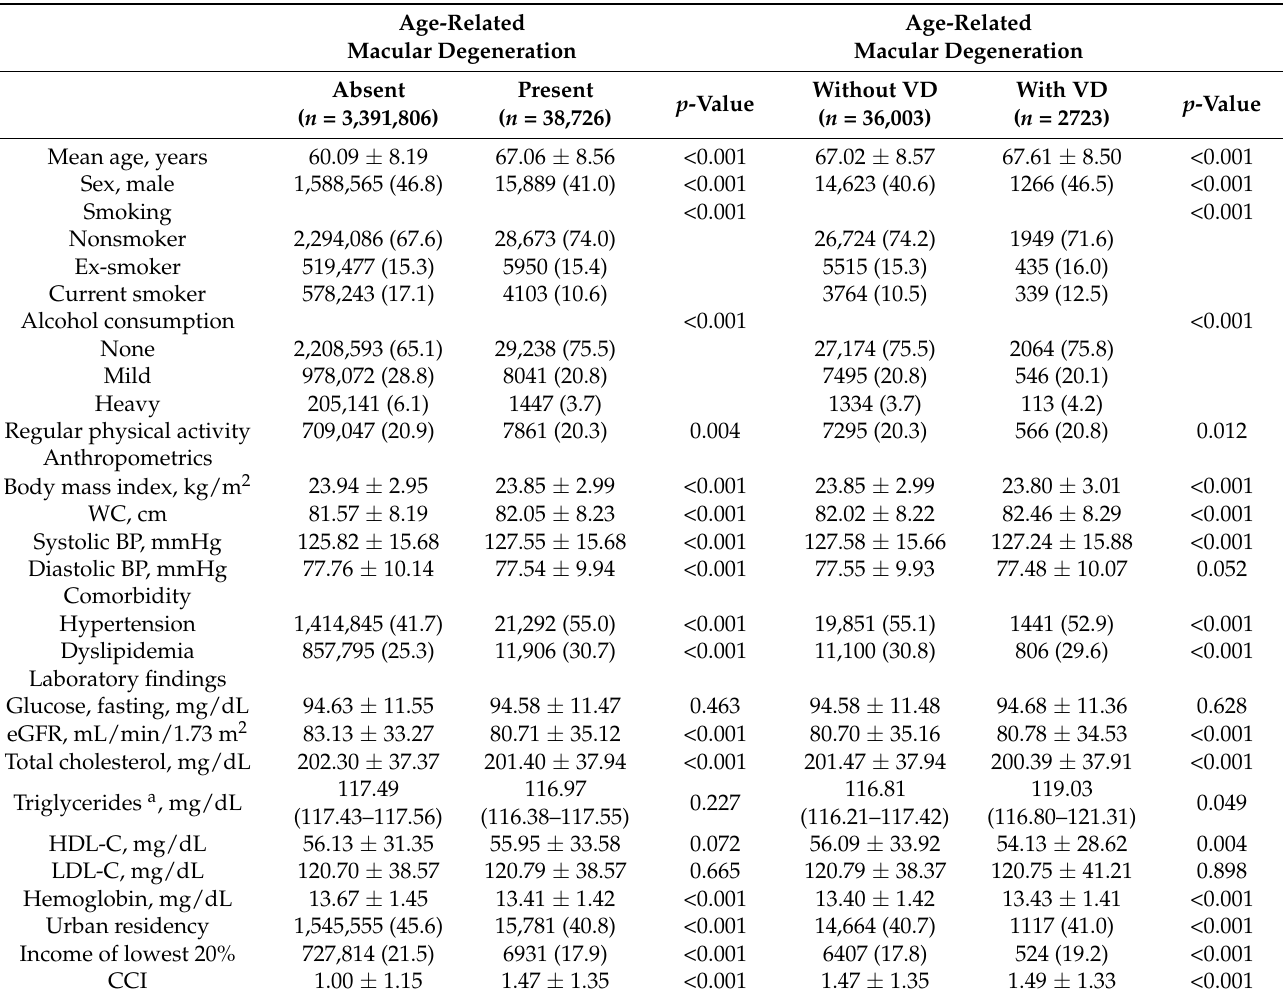
Table 1. Baseline characteristics of the study population according to the presence of age-related macular